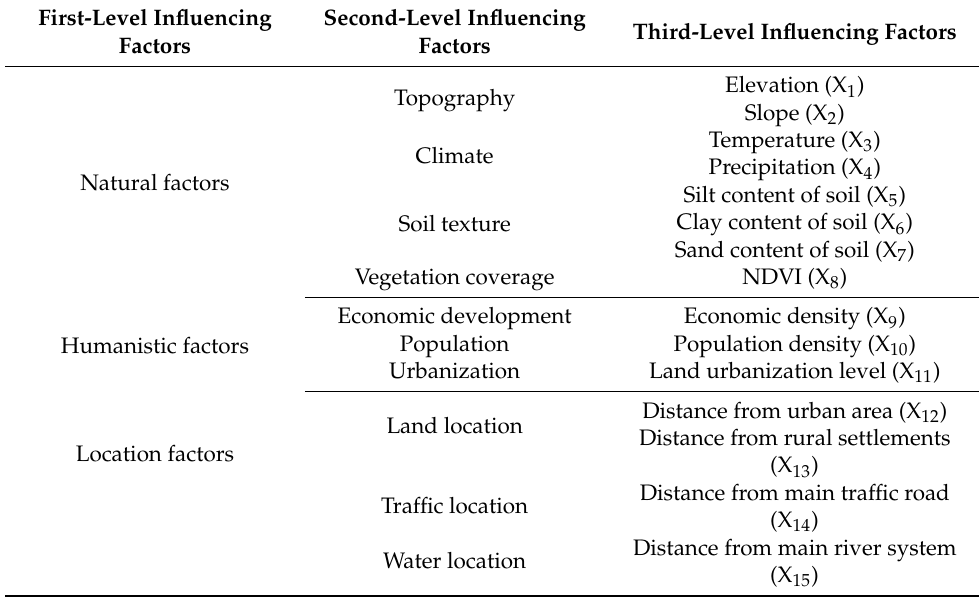
Table 2. Influencing factors of the